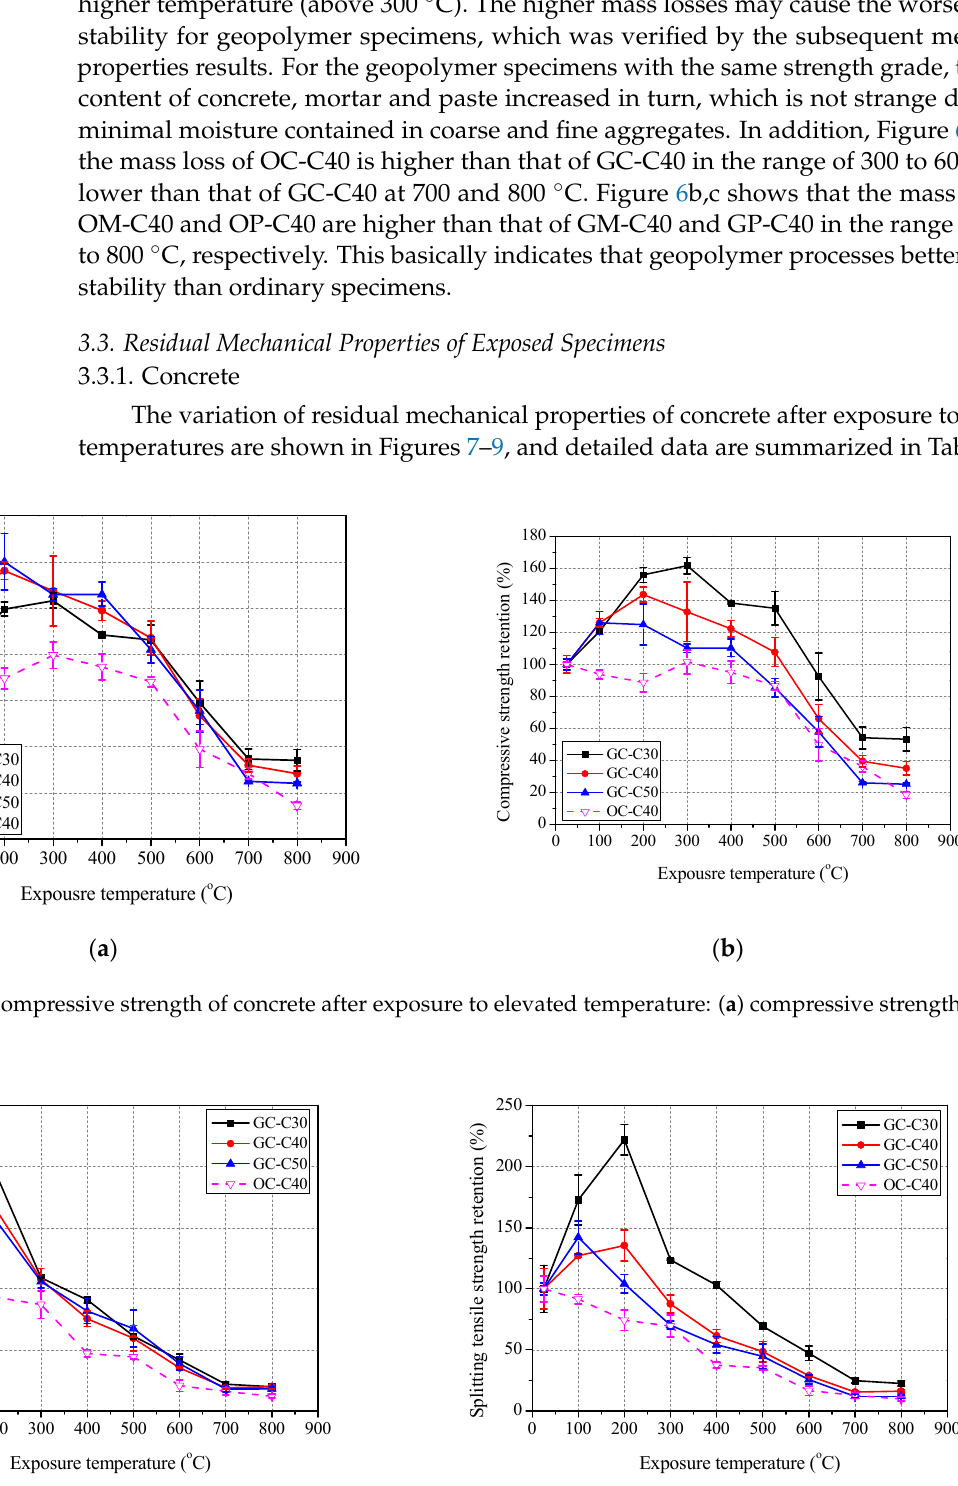
( b ) Figure 9. Residual flexural strength of concrete after exposure to elevated temperature: ( a ) flexural strength and ( b ) reten- tion.